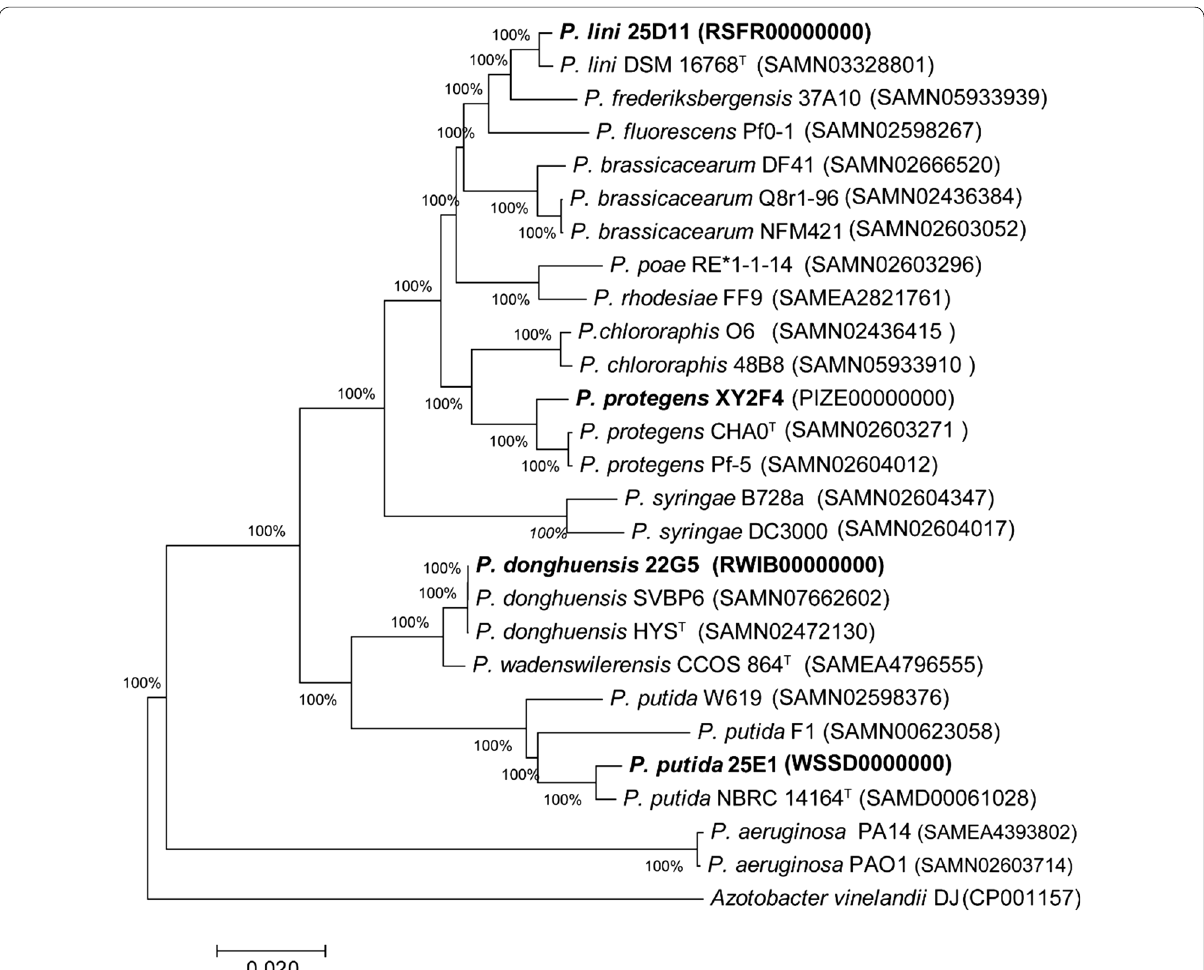
Fig. 2 Phylogenetic tree depicting the evolutionary relationships of Pseudomonas spp. Genomes of previously reported strains were downloaded from The Pseudomonas Genome Database (https ://www.pseud omona s.com/). The annotation was performed using RAST (Overbeek et al. 2014). The phylogenetic tree was generated with MEGA software using concatenated sequences of 10 housekeeping genes ( acsA , aroE , dnaE , guaA , gyrB , mutL , ppsA , pyrC , recA , and rpoB ) (Loper et al. 2012). Strains in this study are indicated with a star (*). Type strains or representative strains of multiple documented Pseudomonas species were compiled to build the tree. Azotobacter vinelandii DJ was used as the